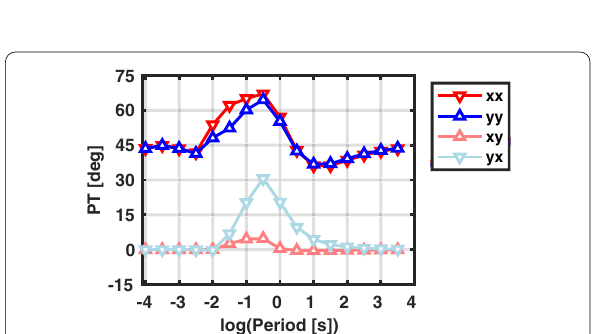
Fig. 3 Synthesized PT elements in arctangent scaling corresponding to MT impedance elements at station syn‑0403 (Fig.